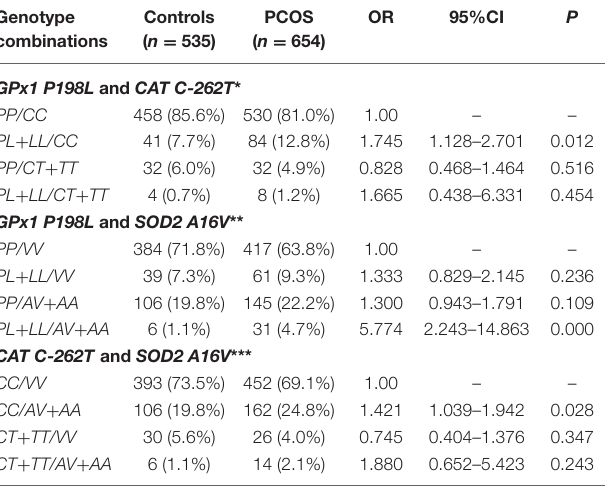
TABLE 3 | Frequencies of combined genotypes of GPx1 P198L and CAT C-262T, GPx1 P198L and SOD2 A16V, and CAT C-262T and SOD2 A16V in patients with PCOS and the control